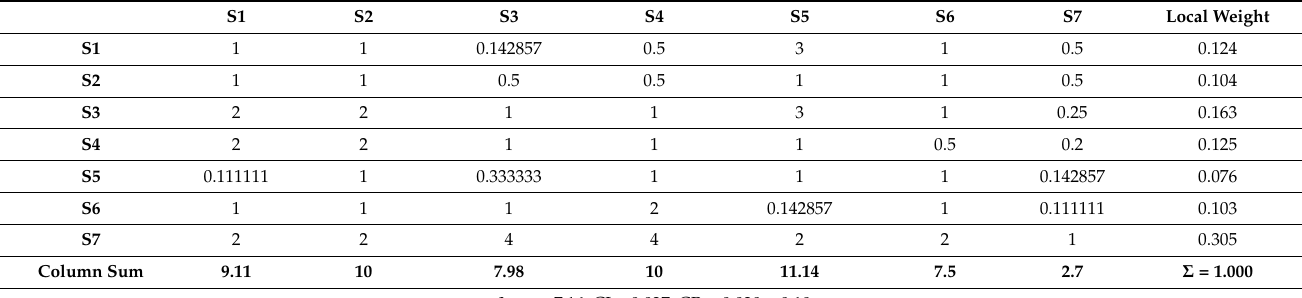
Table 10. Pairwise comparison for “Strengths” category.